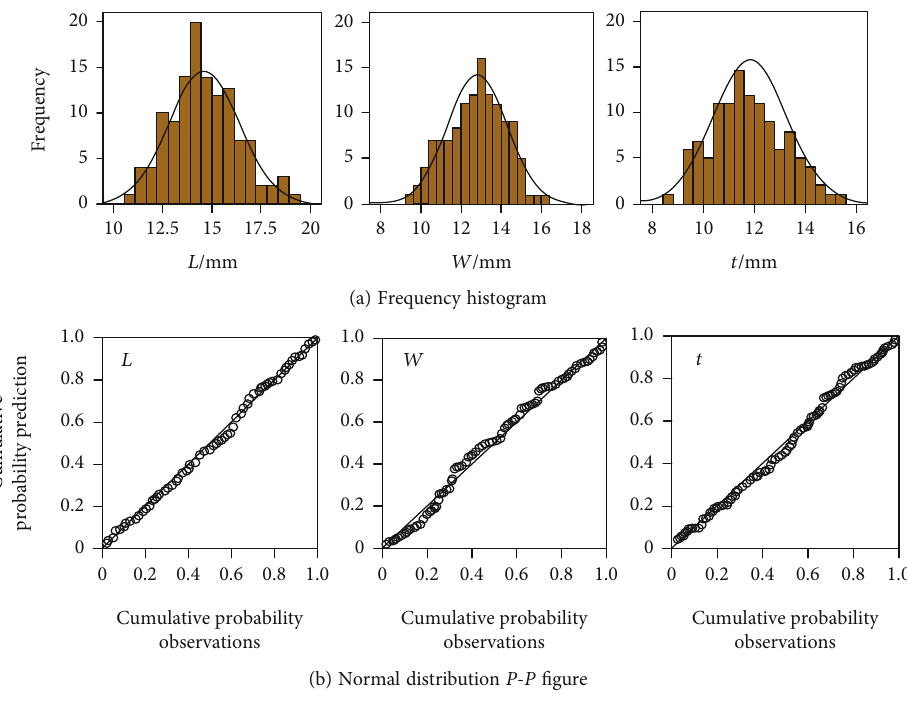
Figure 5: Frequency histogram and normal distribution P ‐ P fi gure of L , W , t , L / t , and AC .